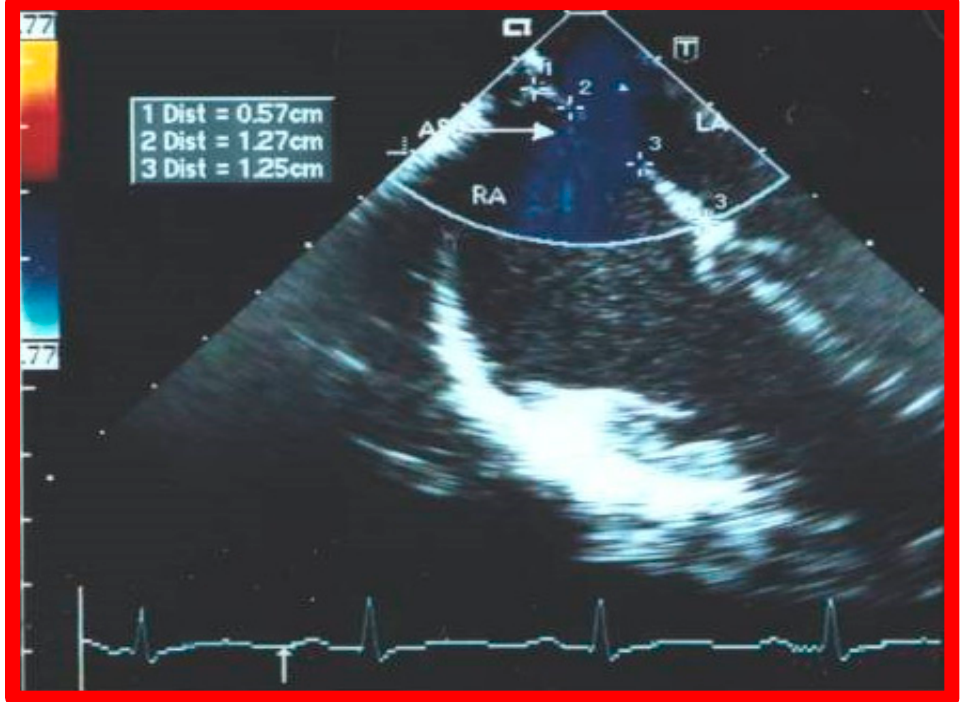
Figure 18. Transesophageal echocardiographic study of an atrial septal defect (ASD) in a four-chamber view demonstrating an ASD (arrow) with shunting left to right. The insert shows dimensions of superior rim (1), ASD (2), and inferior rim (3) in that order. LA, left atrium; RA, right atrium. Reproduced from Reference [3].